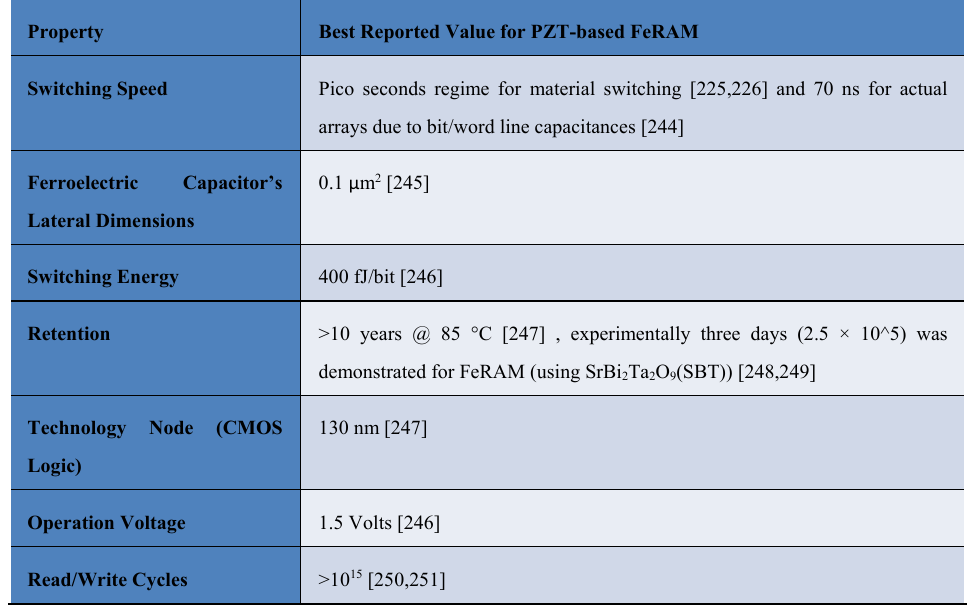
Table 7. Summary of best reported values for PZT- based ferroelectric nonvolatile memory